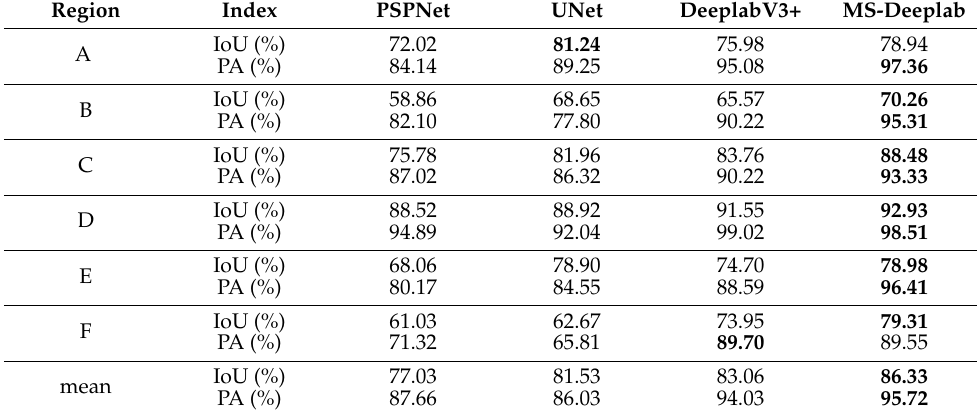
Table 4. Evaluation of segmentation results by different